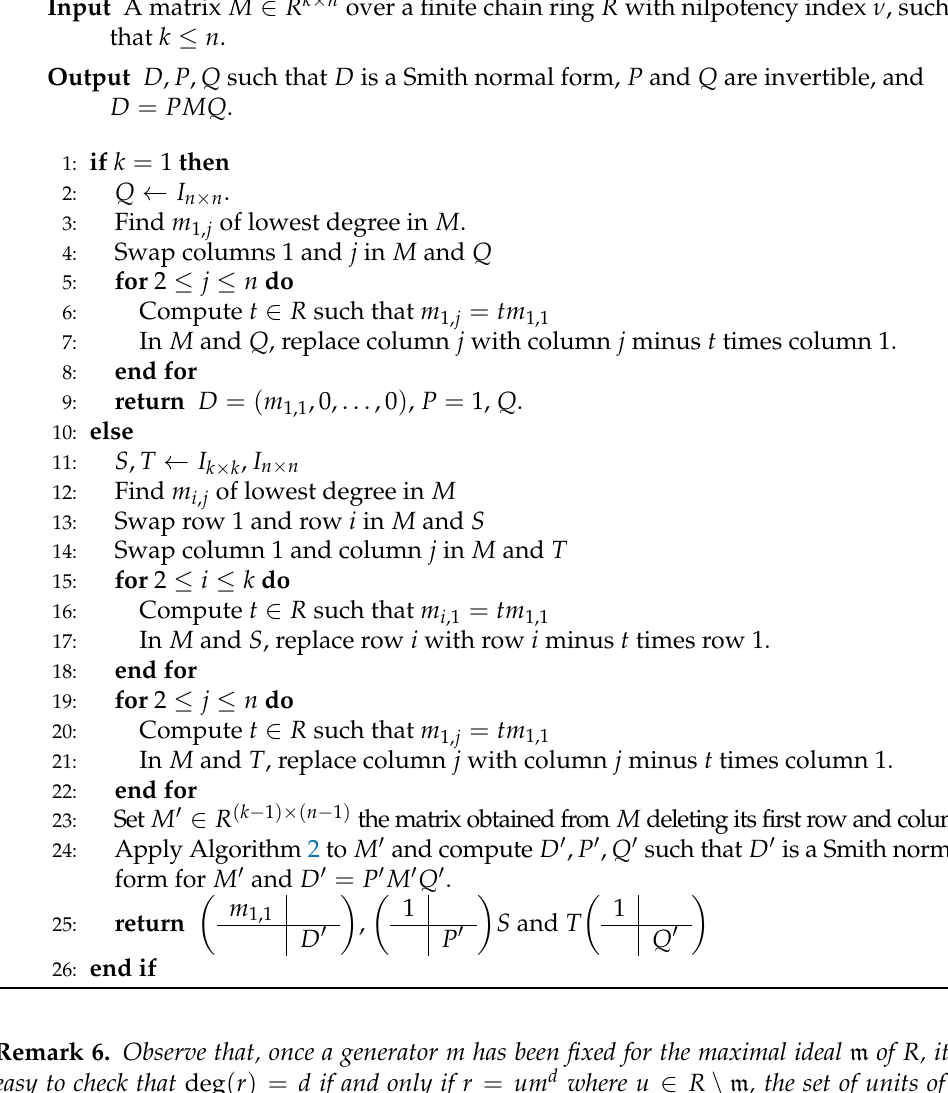
Algorithm 2: Smith normal form for finite chain